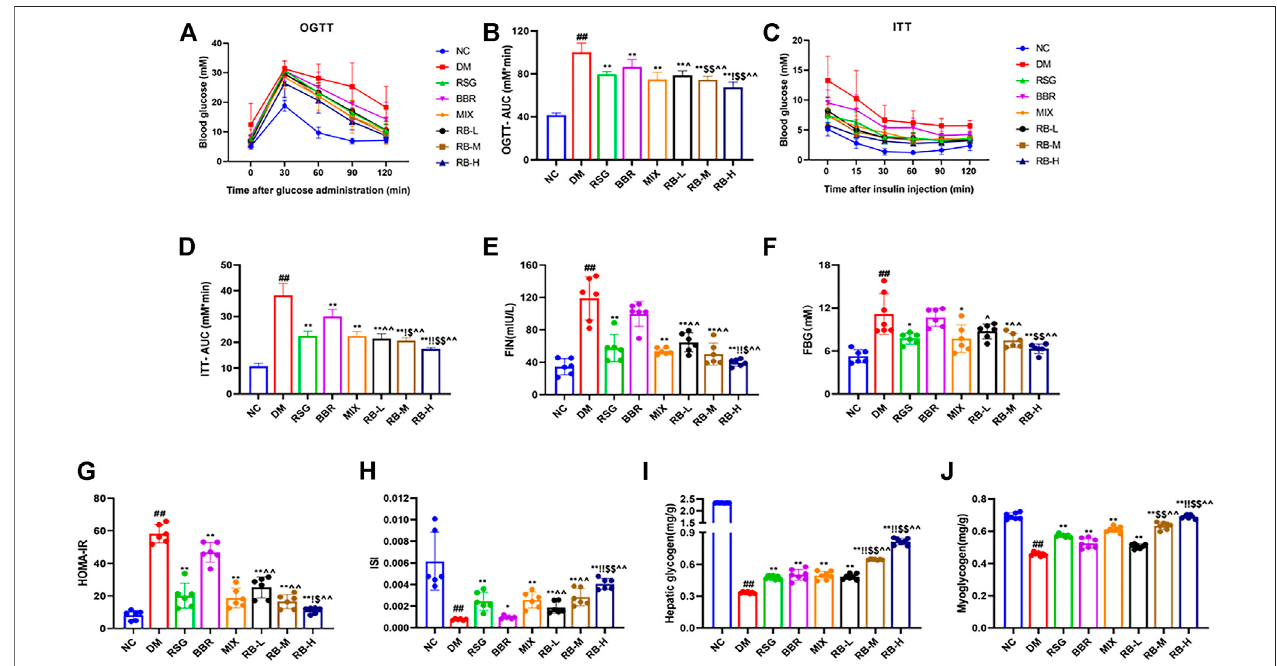
FIGURE 2 | RB improved glucose metabolism in T2DM KKAy mice. (A) Oral glucose tolerance test (OGTT), n = 7 per group; (B) Area under the curve (AUC) of OGTT; (C) Insulin tolerance test (ITT), n = 7 per group; (D) AUC of ITT; (E) Fasting serum insulin (FIN); (F) Fasting blood glucose (FBG); (G) Homeostasis model assessment of insulin resistance (HOMA-IR); (H) Insulin sensitivity index (ISI); (I) Hepatic glycogen content; (J) Myoglycogen content. Data are expressed as the mean ± SD. # p < 0.05, ## p < 0.01, vs. NC group; * p < 0.05, ** p < 0.01,vs. DMcontrolgroup; $ p < 0.05, $$ p < 0.01, vs. RSGgroup; ^ p < 0.05, ^^ p < 0.01, vs. BBRgroup; ! p < 0.05, !! p < 0.01, vs. MIX